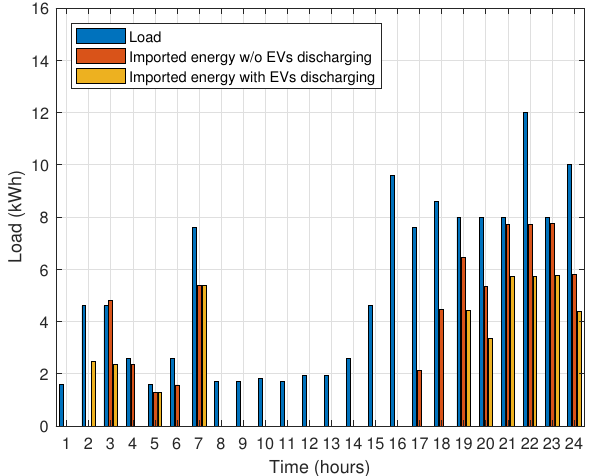
Figure 15. Imported/purchased energy with and W/O EVs discharging. The diesel generator, when used with microgrid as a backup, releases a lot of carbon into the environment, which highly contributes to pollution. Thus, adopting a diesel generator as a back source is not a vital solution. On this note, MGT with microgrid is used as a backup source, which highly contributes to reducing carbon emission, leading to a clean environment. The obtained results of carbon emission reduction when MGT is used as backup sources with microgrid are shown in Figure 16. Thus, the use of MGT results in reduction of 25% carbon compared to a diesel